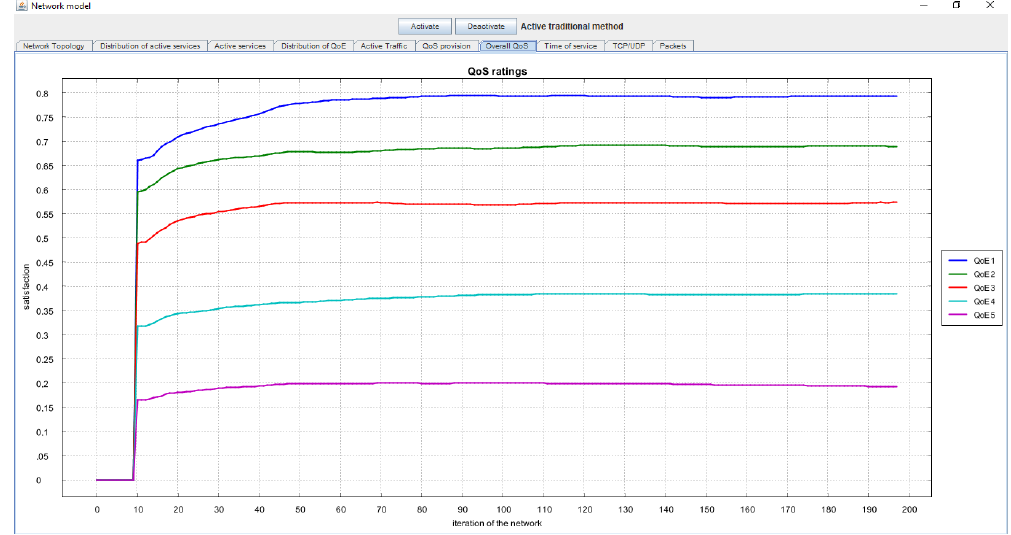
Figure 26. Customer satisfaction according to QoE ratings using the traditional method.